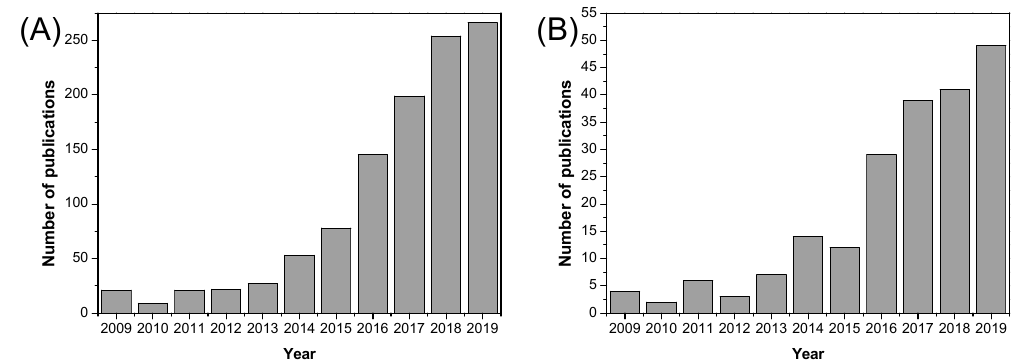
Figure 20. Number of publications in the period of 2009–2019 indexed in the Web of Science: ( A ) keywords: metal organic framework AND fuel cell; and ( B ) keywords: metal organic framework AND fuel cell AND proton exchange membrane. Source: www.webofknowledge.com.